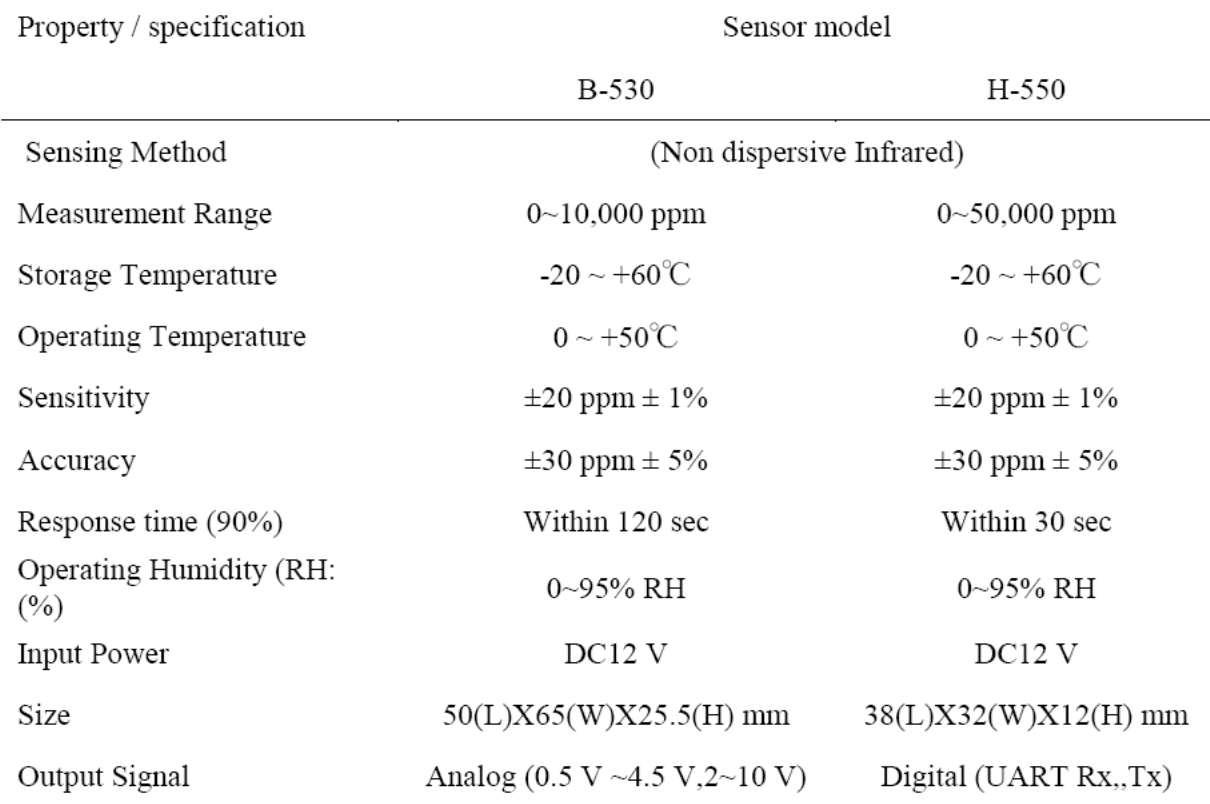
Table 1. A brief description of general properties and specifications pertaining to two types of NDIR-based CO sensors used in this study. 2